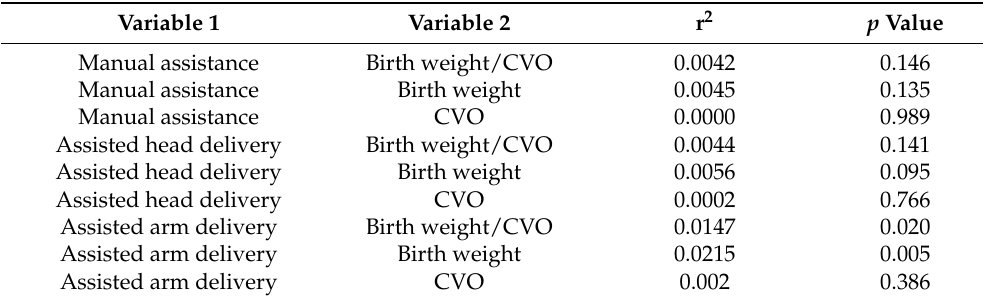
Table 5. Vaginal deliveries in an upright position–logistic regression analasis of manual